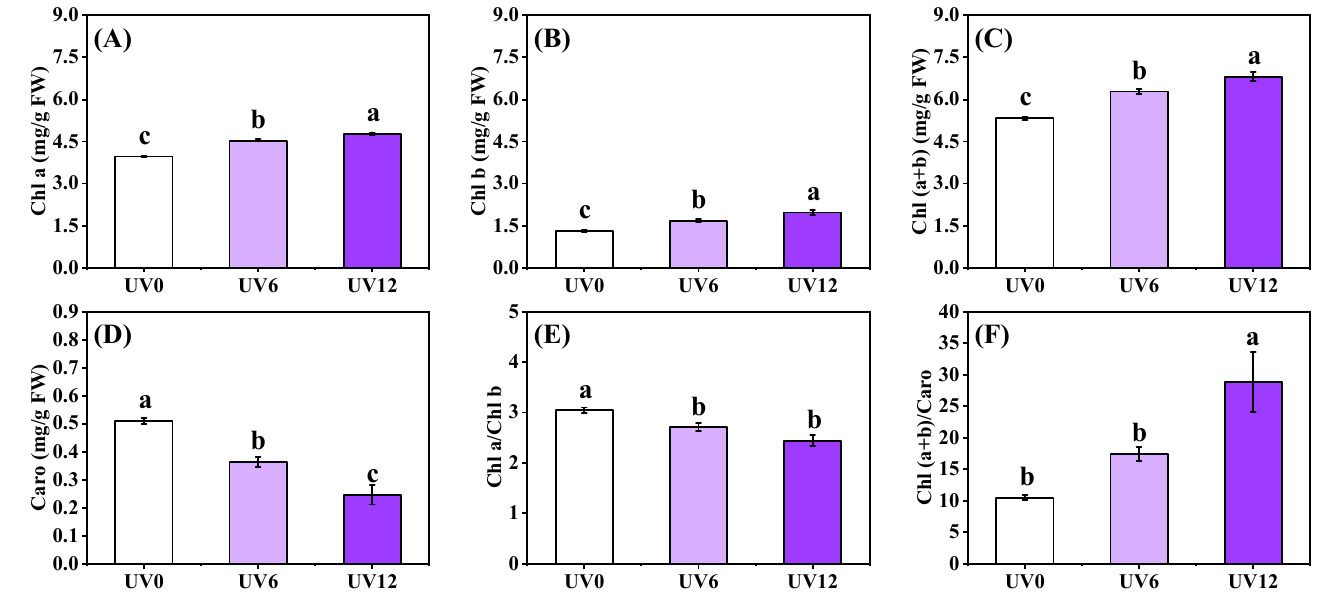
Figure 3. Leaf pigment content of Chinese kale subjected to different durations of UVA-radiation exposure. ( A ) Chl a. ( B ) Chl b. ( C ) Chl (a + b). ( D ) Caro. ( E ) Chl a/Chl b. ( F ) Chl (a + b)/Caro. Different lowercase letters (a–c) labeled on the vertical bar (means ± standard error, n = 3) represent significant differences by one-way ANOVA with multiple-range tests ( p ≤ 0.05).